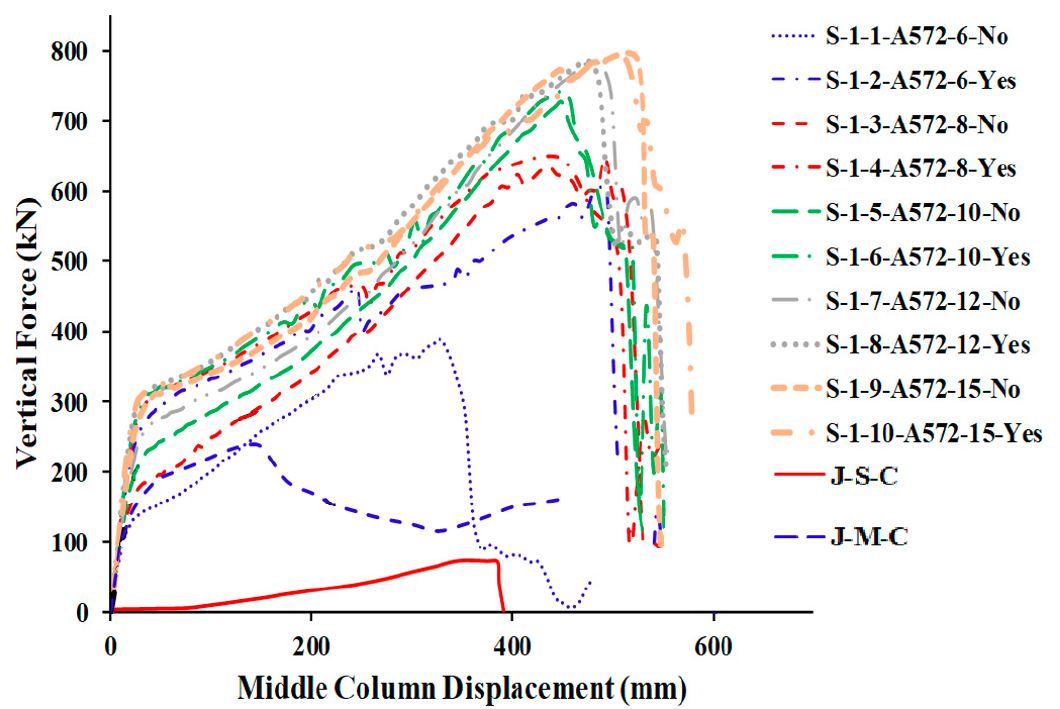
Figure 16. FEM force-displacement response for all A572 steel-specimens. Table 5. Comparison of FEM results for welded specimens in terms of different plate thicknesses with two steel grades (A572 & A36).